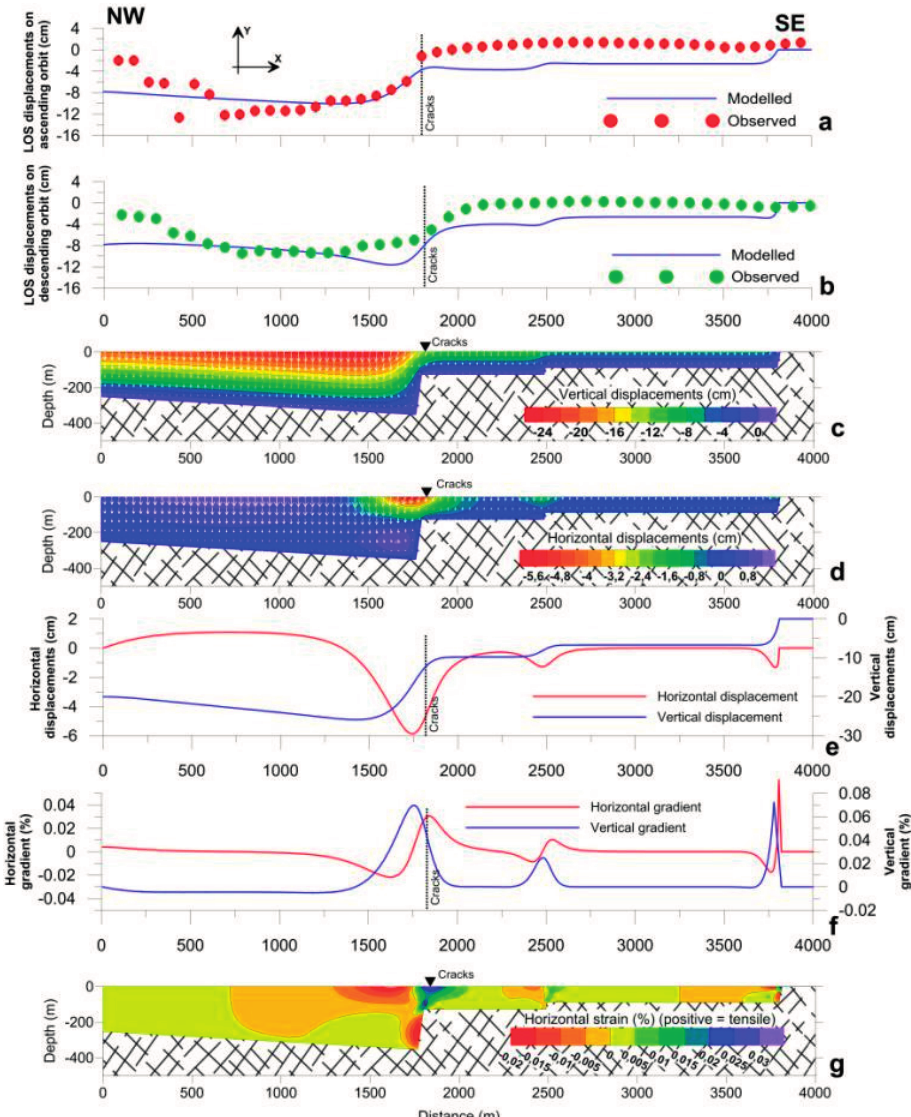
Figure 11. Comparison between calculated and observed LOS displacements considering the cumulated displacements of ( a ) ascending and ( b ) descending ENVISAT data. ( c ) Vertical and ( d ) horizontal displacement contours, together with the resultant displacement vectors. ( e ) Horizontal and vertical displacement profiles at the ground level. ( f ) Horizontal and vertical gradient at the ground level. ( g ) Contour of the horizontal strains after the lowering of the water